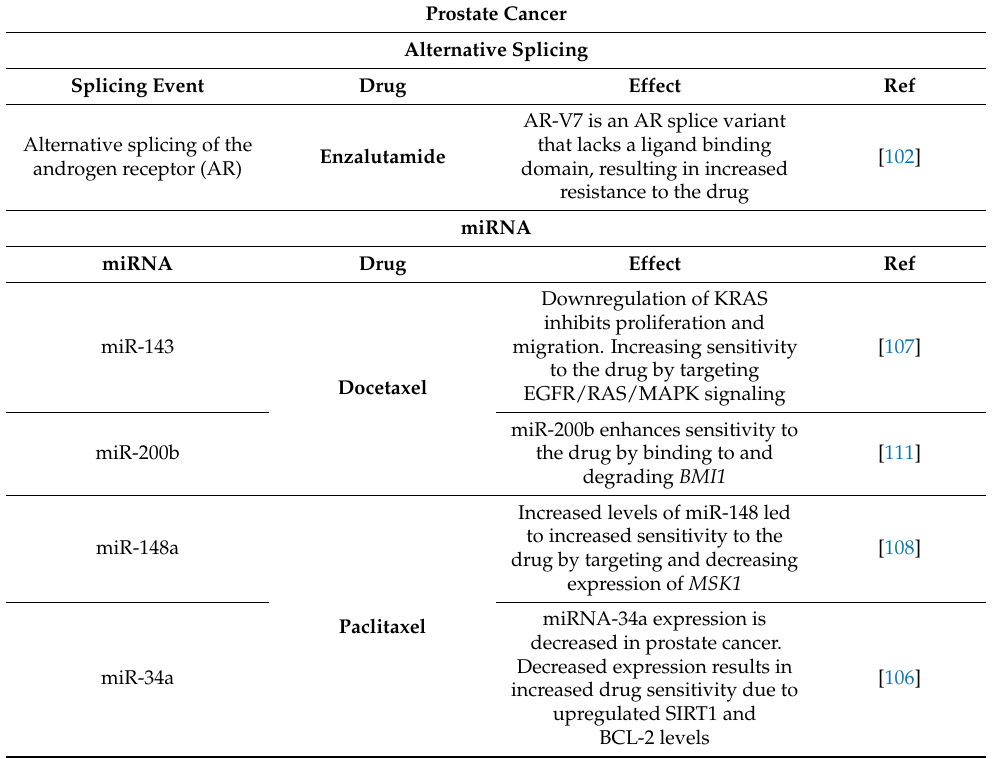
Table 3. Alternative splicing events and miRNAs involved in drug resistance in prostate cancer